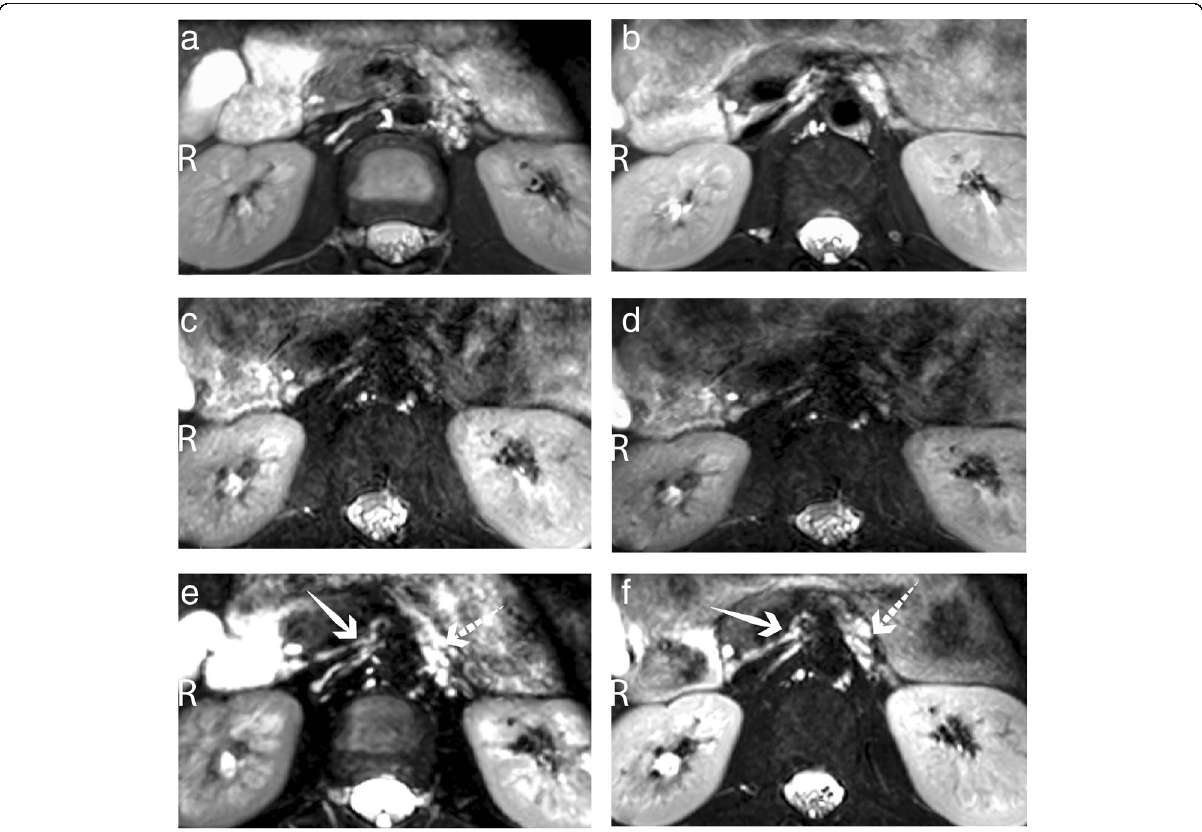
Fig. 2 Typical axial-acquired image, centred at the level of the celiac trunk, obtained with 3D T2-weighted TSE and 3D SHINKEI sequences in the healthy volunteer #1. 3D SHINKEI images with respiratory triggering only at 1.5 T ( c ) and 3 T ( d ) show significant motion artifacts: blurring, signal loss, and noise band in phase direction. These artifacts mostly disappeared after adding cardiac synchronisation to the 3D T2-weighted TSE sequence at 1.5 T ( a ) and 3 T ( b ) or to the 3D-SHINKEI sequence at 1.5 ( e ) and 3 T ( f ). The right (solid white arrows) and left ganglia of the celiac plexus (dashed white arrow) are clearly distinguishable as hyperintense